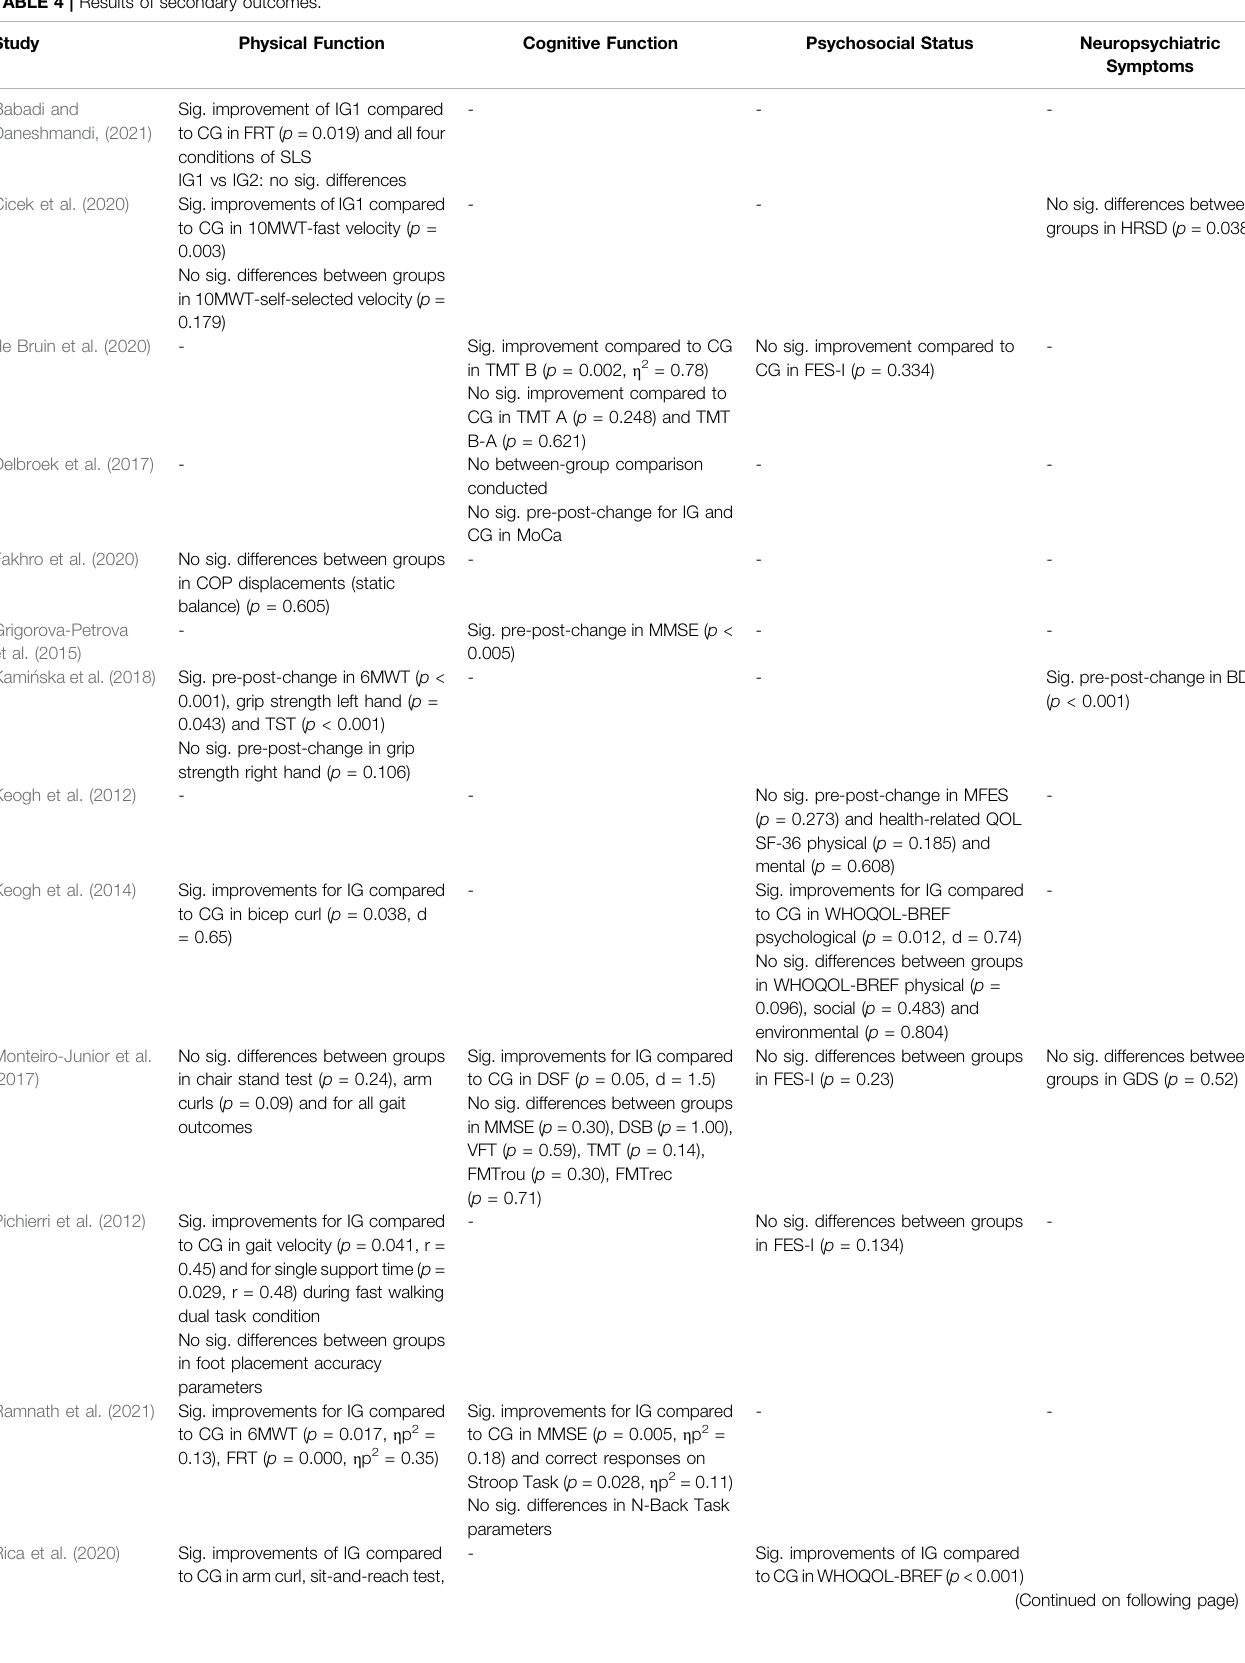
TABLE 4 | Results of secondary